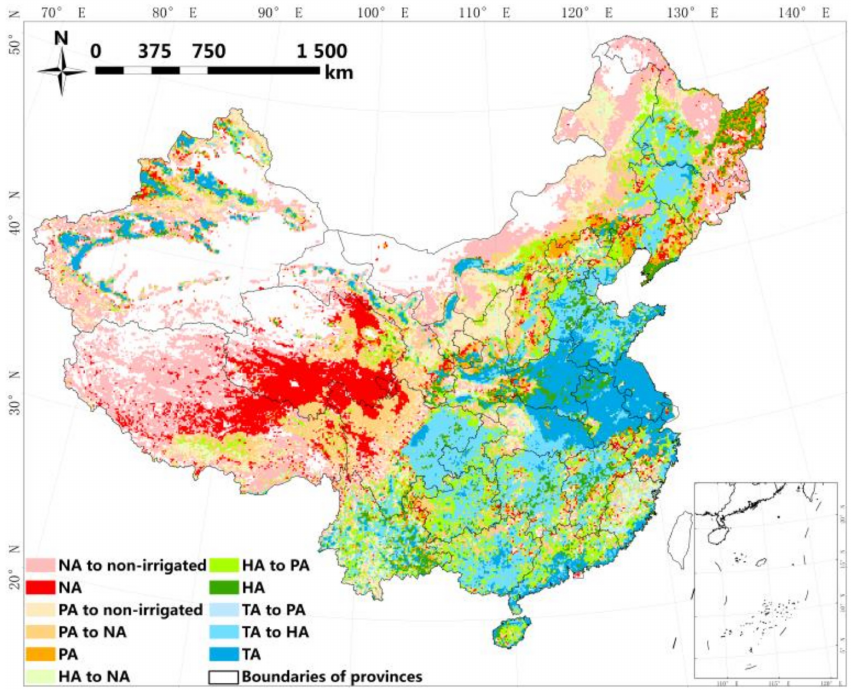
Figure 6. Alteration of agreement following exclusion of mosaic cropland pixels (MCPs). NA, PA, HA and TA is short for no agreement, partial agreement, high agreement and total agreement respectively, which has the same meaning in the